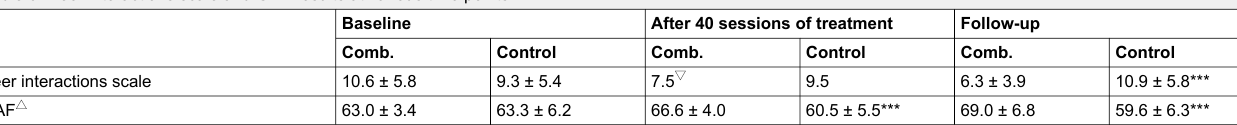
Table 3: Peer interactions scale and GAF results at various time points.